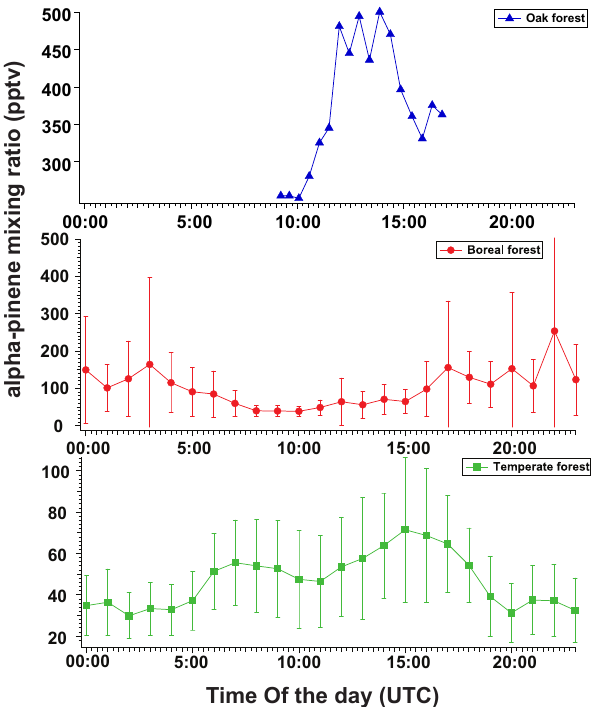
Fig. 8. Diel cycle of α -pinene mixing ratios during the measure- ment period. For boreal forest and temperate forest measurements, the marks represent the mean value of every hour, the error bars were the standard deviation (boreal forest: n >13; temperate forest: n >12); for oak forest measurements, the solid triangle represents the mixing ratio observed.